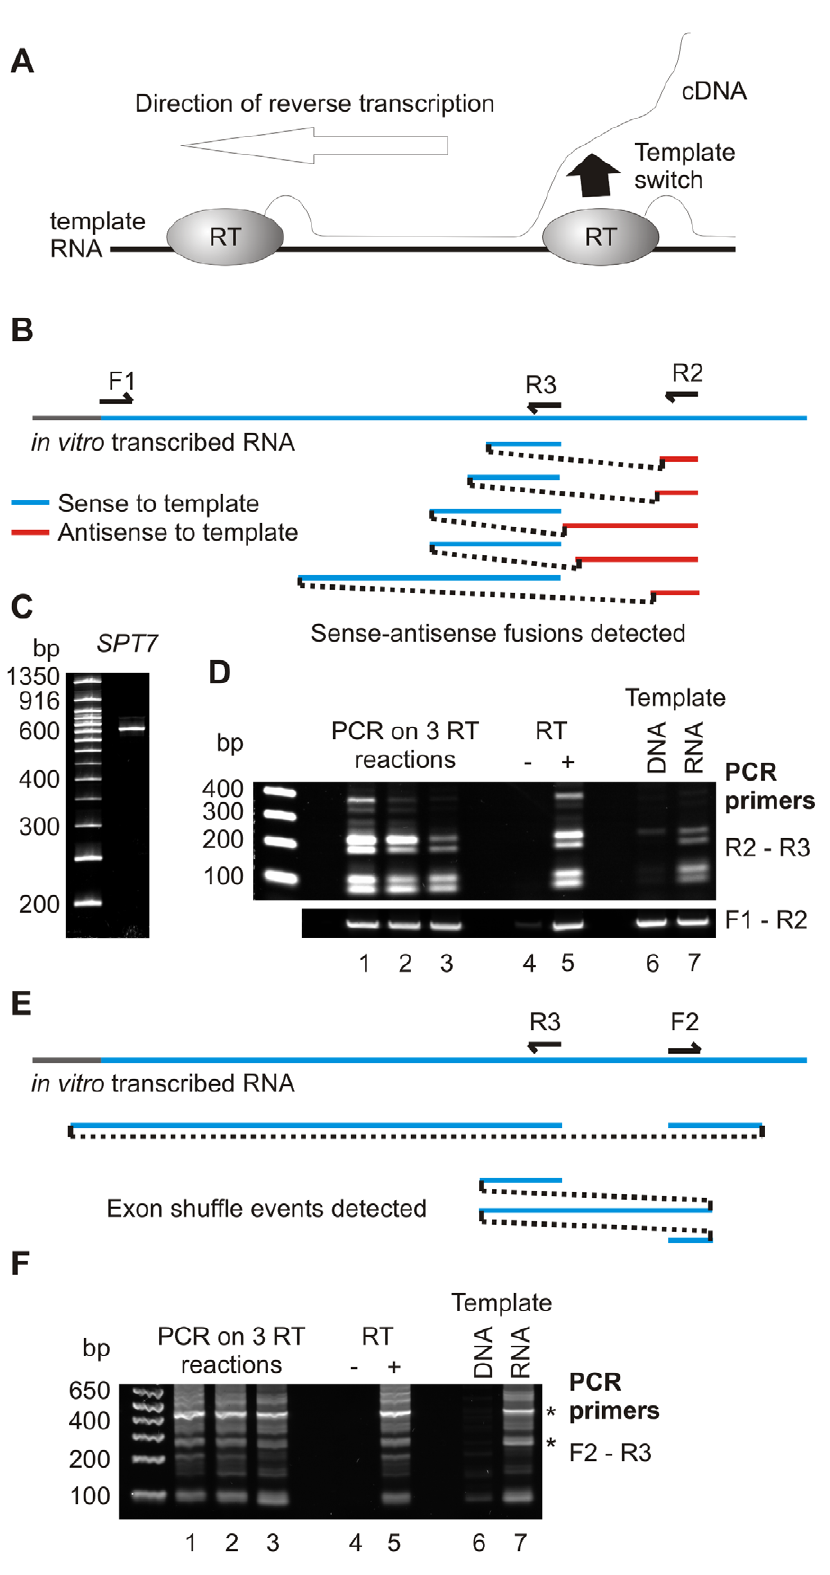
Figure 3. Invitro formation of sense-antisense fusions. A: Proposed mechanism of sense-antisense fusion formation. B: Schematic of SPT7 RNA showing primer binding sites and observed sense-antisense fusions. C: Purified SPT7 substrate. D: RT-PCR experiments performed on SPT7 substrate performed as in Fig. 2C. Upper panel shows a 32 cycle PCR reaction, other panels show 25 cycles. E: Schematic of SPT7 RNA showing primer binding sites and observed exon shuffling events. F: RT-PCR experiments performed as in d. Sequenced bands are indicated by *.